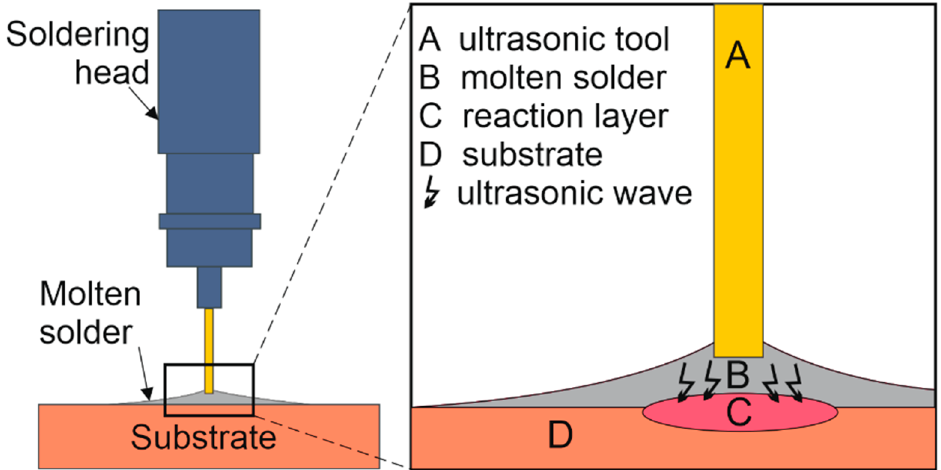
Figure 3. Schematic illustration of ultrasonic activation on the substrate surface.